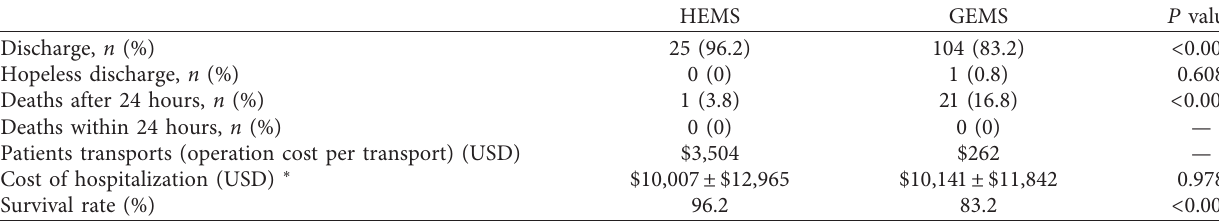
Table 2: Discharge and death